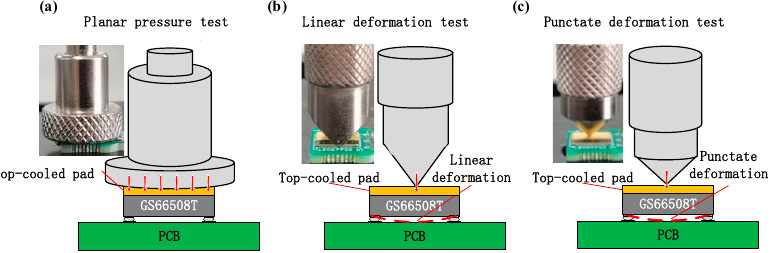
Figure 2. Schematic diagram and physical picture of the experimentally applied planar pressure ( a ), linear deformation ( b ), and punctate deformation ( c ) to GS66508T.